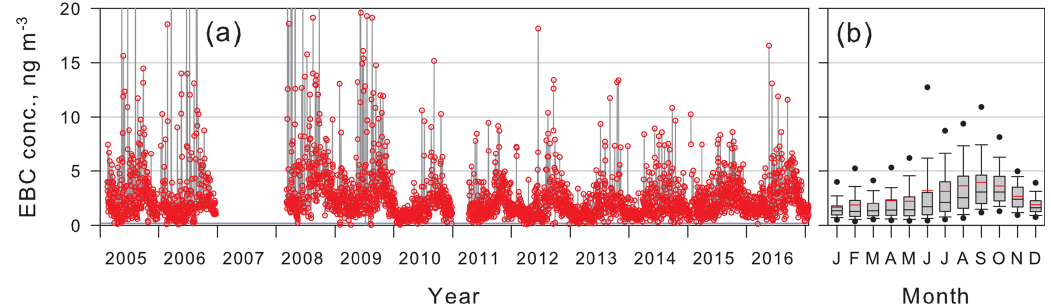
Figure 3. Seasonal features of (a) daily median EBC concentrations and (b) monthly box plot of EBC concentrations at Syowa from Febru- ary 2005. EBC concentrations were not available in January 2007–January 2008 and January 2011–early April 2011 because of mechanical troubles with the Aethalometer. The blue line in (a) shows the detection limit (0.2ngm − 3 ) in our measurements. In box plots, the upper bar, upper box line, black middle box line, bottom box line, and bottom bar respectively denote values of 90%, 75%, 50% (median), 25%, and 10%. The red line shows mean